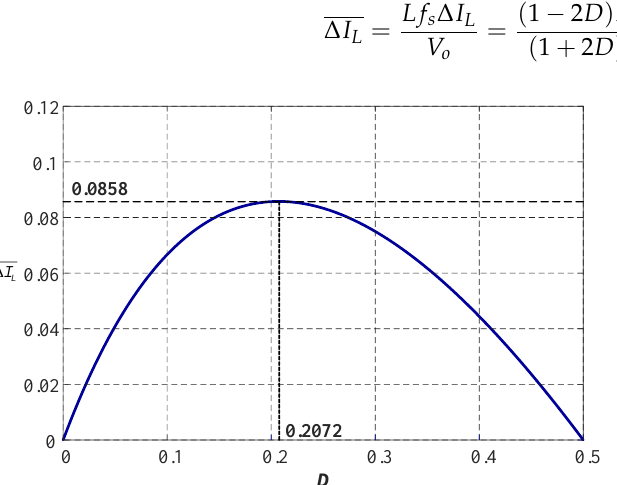
Figure 4. Ripple current through the inductor. The inductance L is determined by reorganizing (5), according to